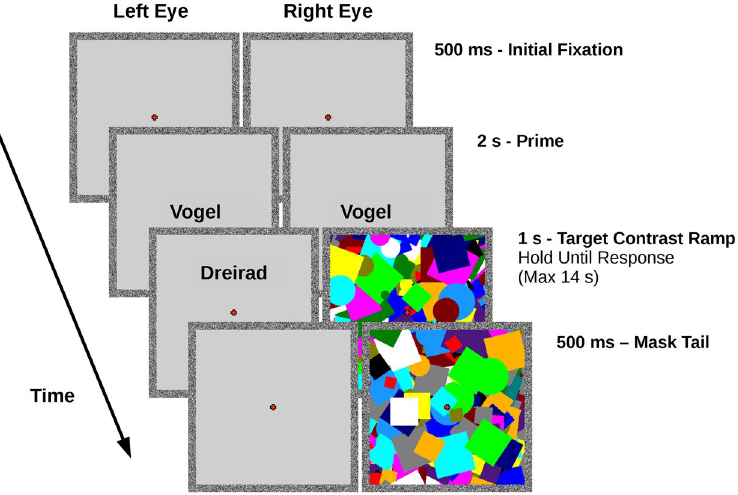
Figure 1. bCFS trial design, with an incongruent prime. Fixation remained at the centre of the screen throughout a trial. Following fixation, a prime word (in this case “Vogel” [bird]) was presented in the centre of the screen for 2 s. Participants were required to respond on the position of the target word (in this case “Dreirad” [tricycle]) relative to the fixation cross (above or below) as soon as they could determine its location. Once the target word was removed (either after participant response or maximum time of 14 s had elapsed) a 500 ms mask tail ensued to obviate afterimages. Note: to aid illustration, contrast and size of words has been